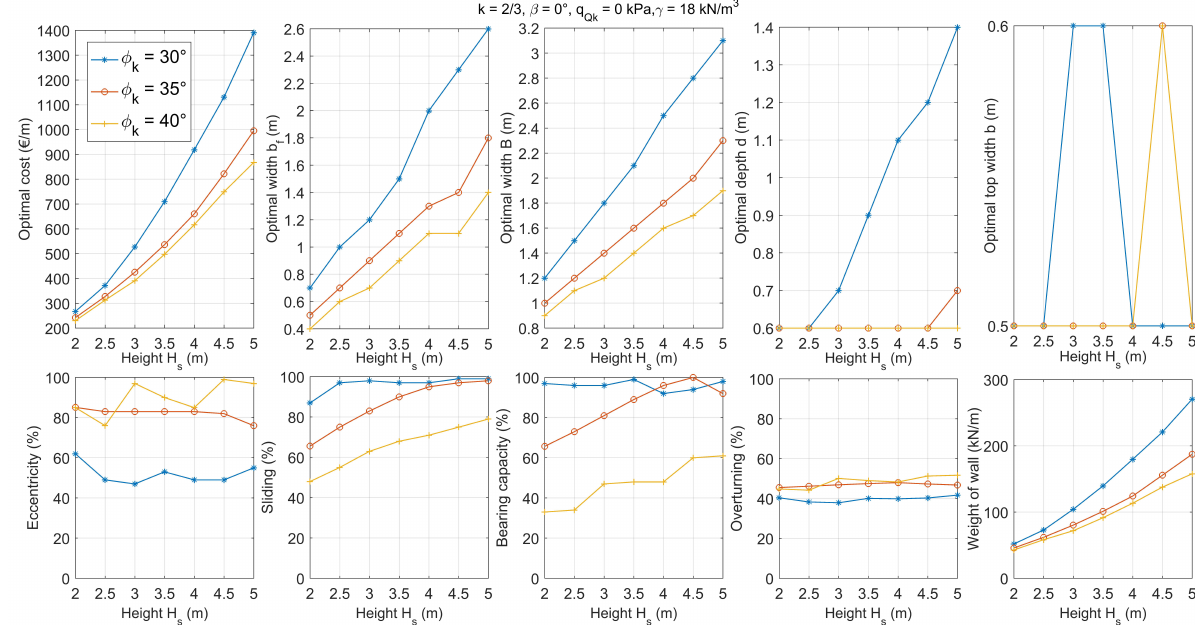
Figure 2. The optimal design of a gravity retaining wall for soil–wall interaction coefficient k = 2/3, slope angle β = 0 ◦ and variable surcharge load q Qk = 0 kPa.